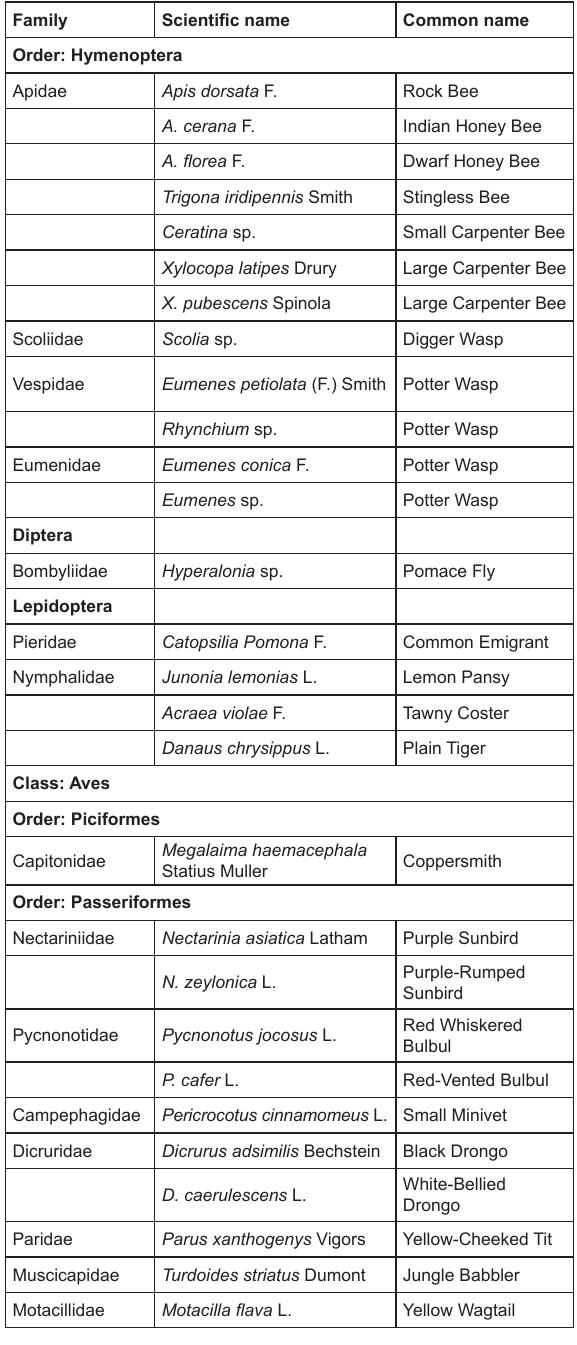
Table 1. List of flower foragers on Boswellia